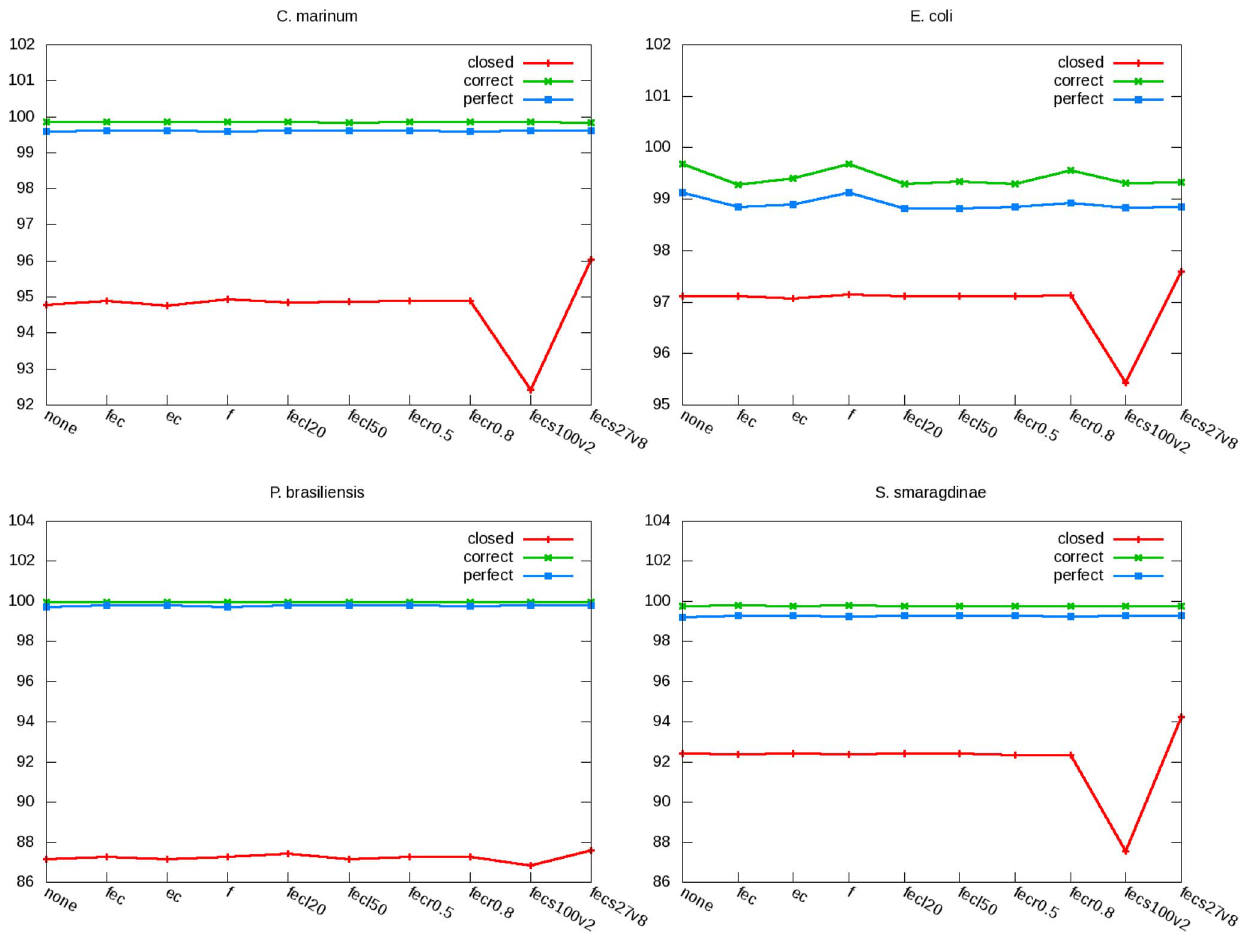
Figure 3. Effects of ARF-PE parameters on the statistics of DNA fragment recovery. Several combinations of ARF-PE parameter values are used to recover DNA fragments from the real data of four bacteria. X-axis indicates the parameter values (f: filtering low-complexity reads, l: minimal number of continuous identical bases for a read to be considered as lowly-complex, ec: error correction to the initial Velvet assembly, r: minimal fraction of consensus bases required for correcting assembly errors, s: seed length of read alignment by SOAP2, v: maximal mismatches allowed in an alignment by SOAP2). Y-axis shows the percentage of DNA fragments that are recovered (red), correctly recovered (green), and perfectly recovered (blue) (the later two values are relative to the number of recovered DNA